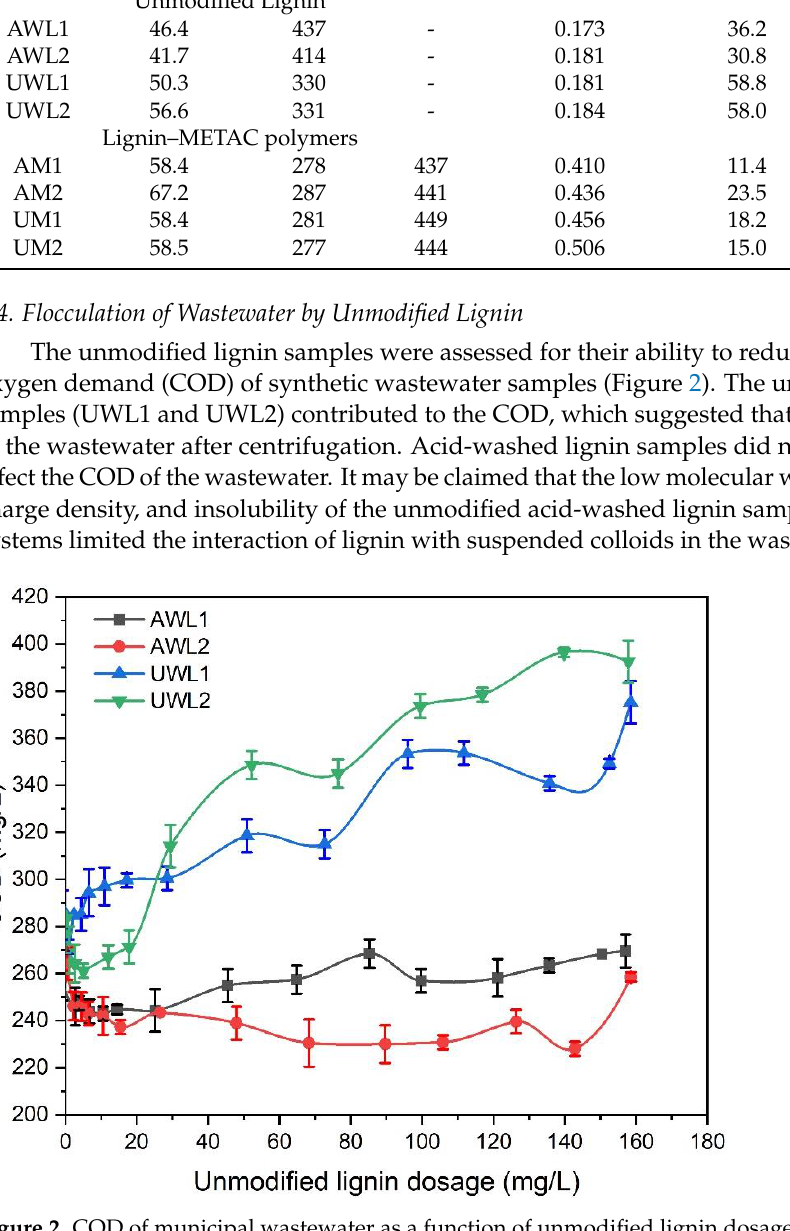
Figure 2. COD of municipal wastewater as a function of unmodified lignin